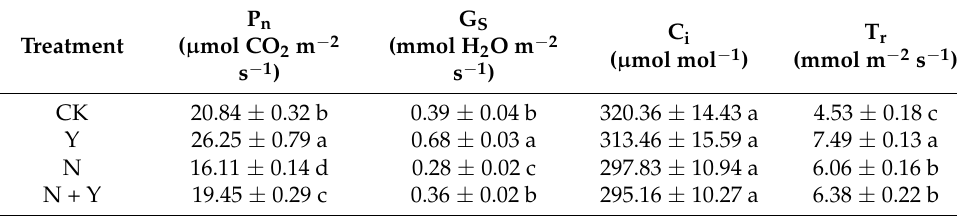
Table 1. Photosynthetic characteristics of cucumber leaves under different treatments.